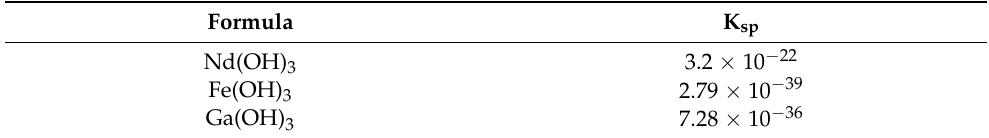
Table 5. Solubility products of the hydroxides at 25 ◦ C [31].